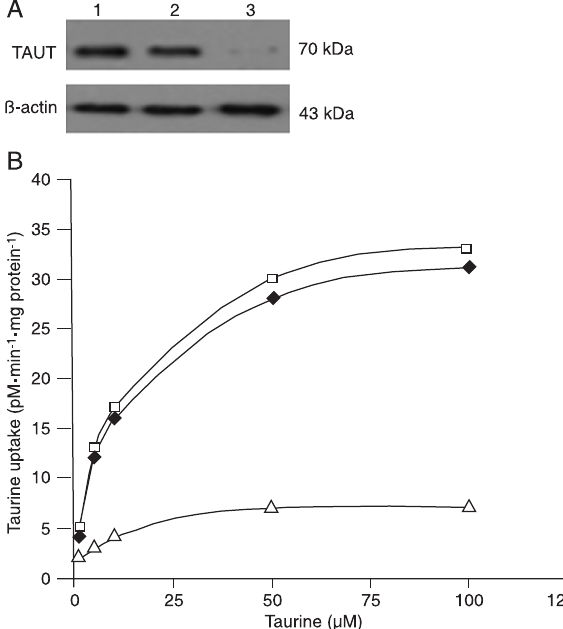
Figure 3. Effects of siRNA-TAUT on TAUT protein expression and taurine uptake in MC3T3-E1 cells. A , Total cell lysates were subjected to Western blot analysis and representative results are shown. Lane 1 : MC3T3-E1 cells; lane 2 : siRNA-control-transfected MC3T3-E1 cells; lane 3 : siRNA-TAUT-transfected MC3T3-E1 cells. B , Uptake of [ 3 H]-taurine by MC3T3-E1 cells (open squares), siRNA-control-transfected MC3T3-E1 cells (filled diamonds), and siRNA-TAUT-transfected MC3T3-E1 cells (open triangles). TAUT = taurine transporter.